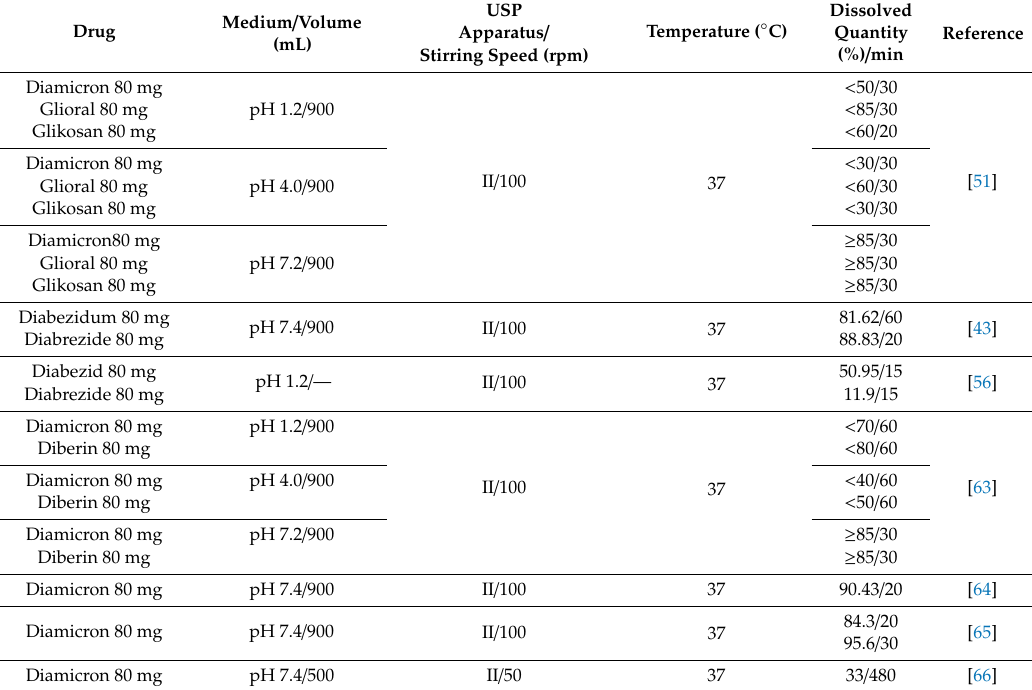
Table 3. Experimental conditions for dissolution studies and percentage amount of gliclazide dissolved from immediate-release solid oral dosage